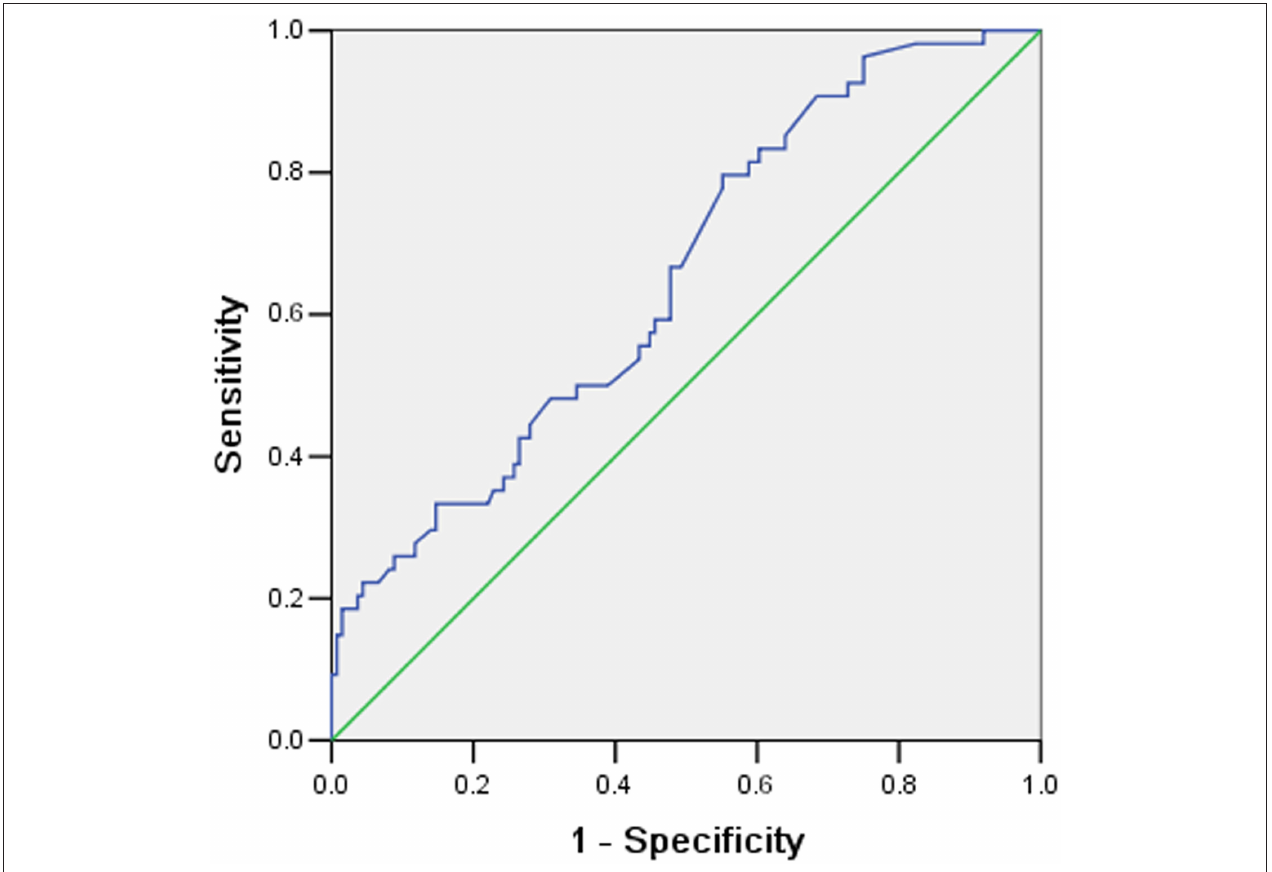
FIGURE 2 | The Receiver operating characteristic (ROC) curves for predicting nosocomial Infection according to extracorporeal membrane oxygenation (ECMO)